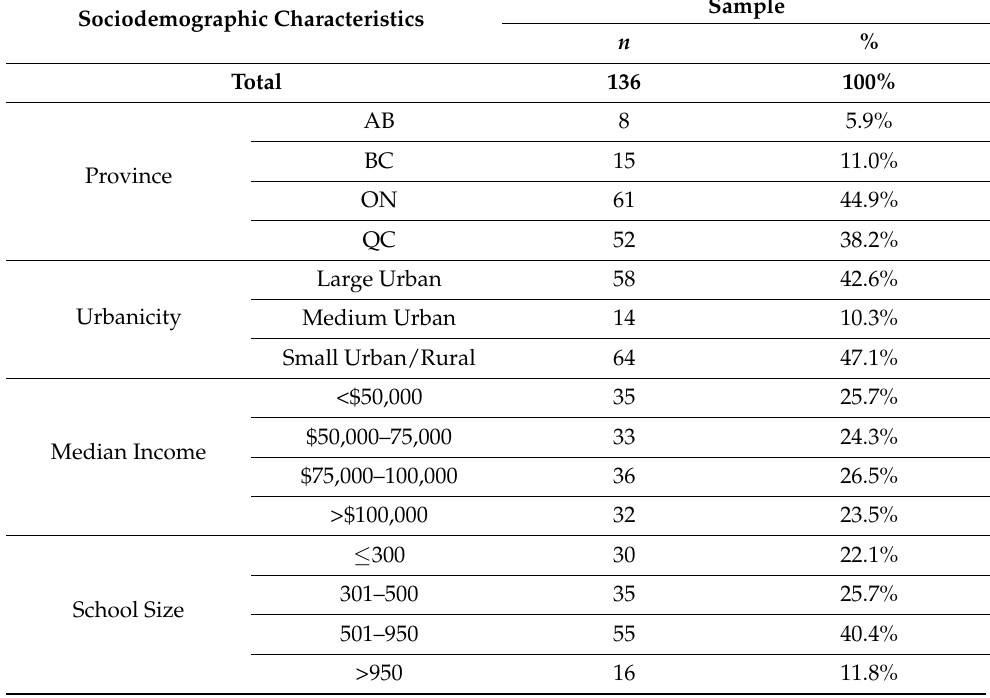
Table A1. Sociodemographic Characteristics of the School Sample ( n = 136) from Y7 of the COM- PASS